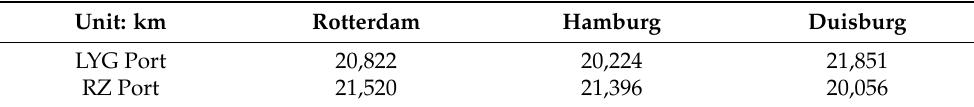
Table A3. Transport distance from seaports to foreign hubs by shipping.